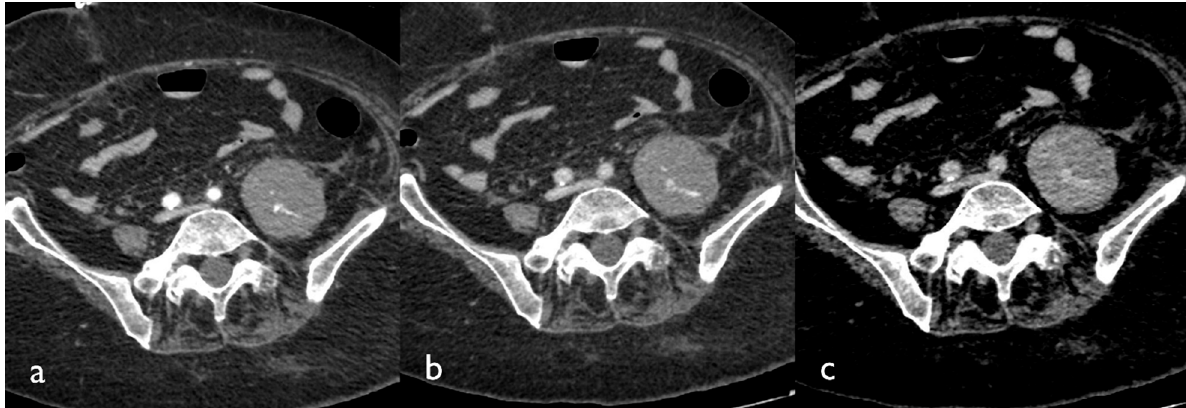
Figure 2. CT images of a patient presenting with a large hematoma of the left iliopsoas muscle. Tri-phase contrast-enhanced axial CT images show contrast blush in the arterial ( a ), portal ( b ), and delayed phase ( c ); active bleeding is seen like small hyperdense foci within the hematoma that appear in the arterial phase and grow in the venous and delayed phase.